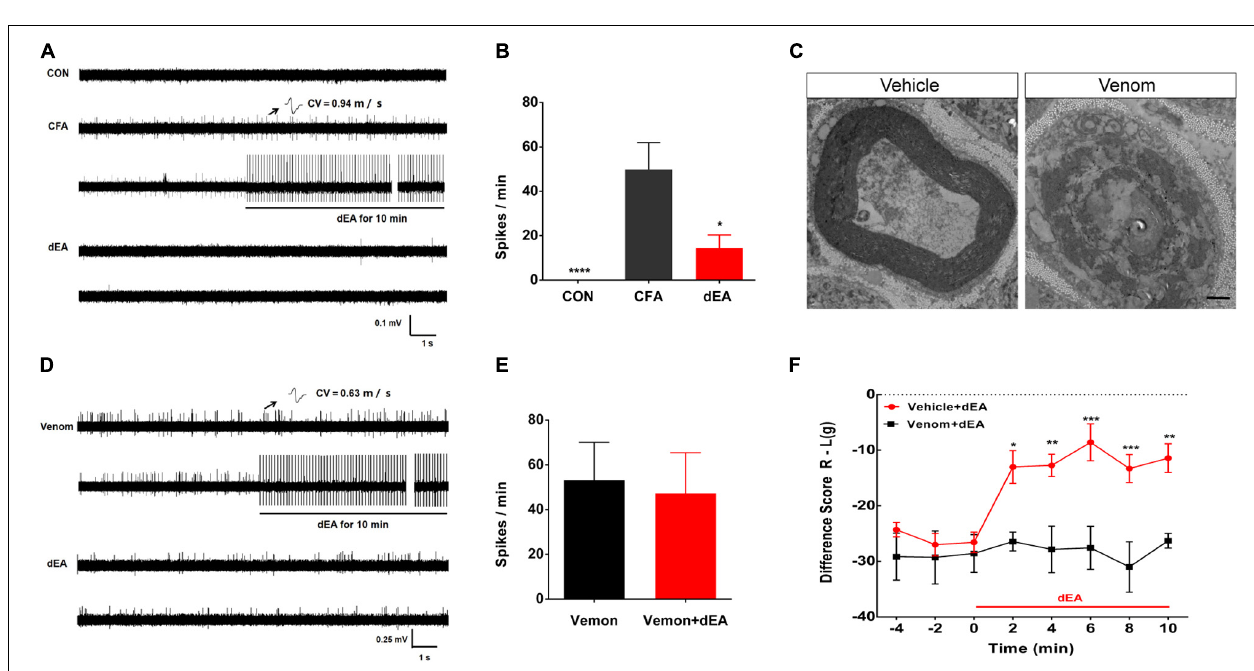
FIGURE 3 | Deep electroacupuncture (dEA) reduced pain to inhibit C-fiber discharges by activating muscular A-fibers. (A) Representative traces showed that there was no C-fiber spontaneous activity in control rats, while complete Freund’s adjuvant (CFA) induced spontaneous activity of C-fibers [conduction velocity (CV) = 0.94 m/s]. The spontaneous activity of C-fiber was substantially inhibited by dEA. (B) Spikes of C-fiber were notably inhibited by dEA. * p < 0.05 or **** p < 0.0001 vs. CFA ( n = 9 fibers). (C) Representative traces showed the demyelination of A-fiber axon after cobra venom injection into the tibial nerve ( n = 2). The axon treated with saline had intact myelin sheath structure ( n = 2). Scale bar, 1 µ m. (D) Typical recordings of a single muscular C-fiber (CV = 0.63 m/s) had spontaneous activity after venom injection and had no response to dEA. (E) Spikes of C-fiber had no obvious response to dEA after venom injection ( n = 10 fibers). (F) Venom completely blocked the effect of dEA on muscular pain. * p < 0.05, ** p < 0.01, *** p < 0.001, significant difference between groups at each of the indicated time points (Holm–Sidak post-test, n =